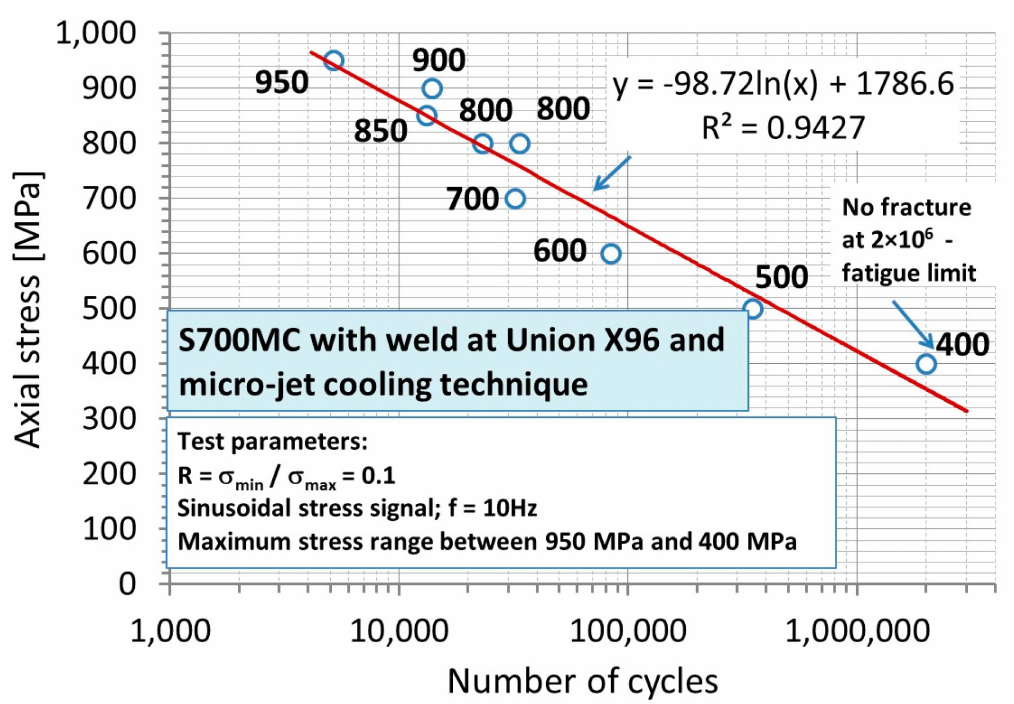
Figure 14. Wöhler curve of S700MC steel welded by means of the welding wire of Union